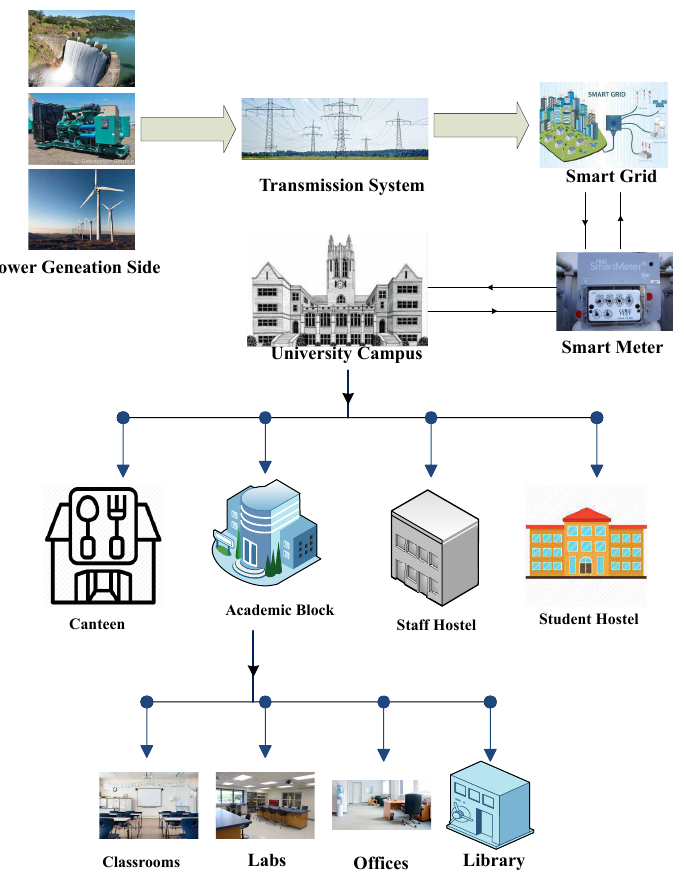
Figure 1. System Model